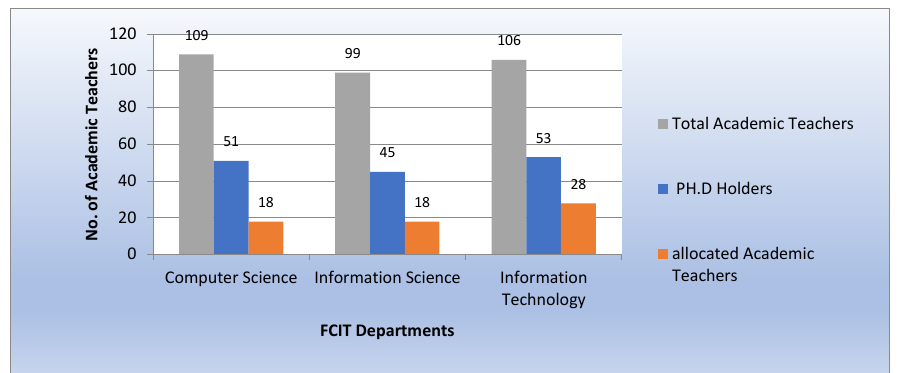
Figure 14. Allocate teachers from the previous study [2].